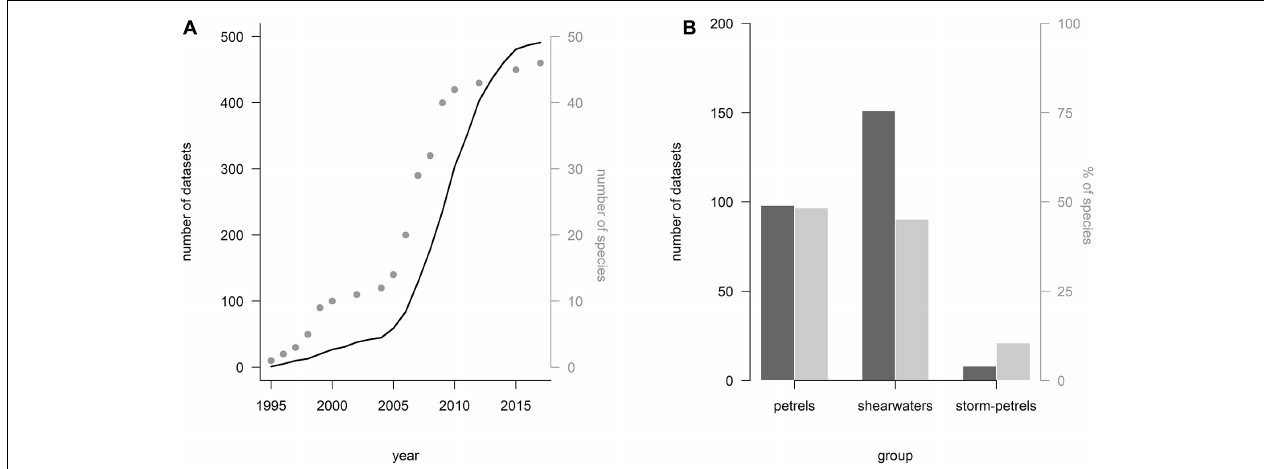
FIGURE 5 | (A) Cumulative number of datasets (i.e., data collected for a single species in a given colony and with a specific type of device – GPS, PTT-Argos or GLS) collected between 1995 and 2018 (line), and cumulative number of species tracked during the same period (points). (B) Number of datasets per petrel groups (black bars) and respective percentages of species (gray bars). Data held (April 2018) in the Seabird Tracking Database (BirdLife International,